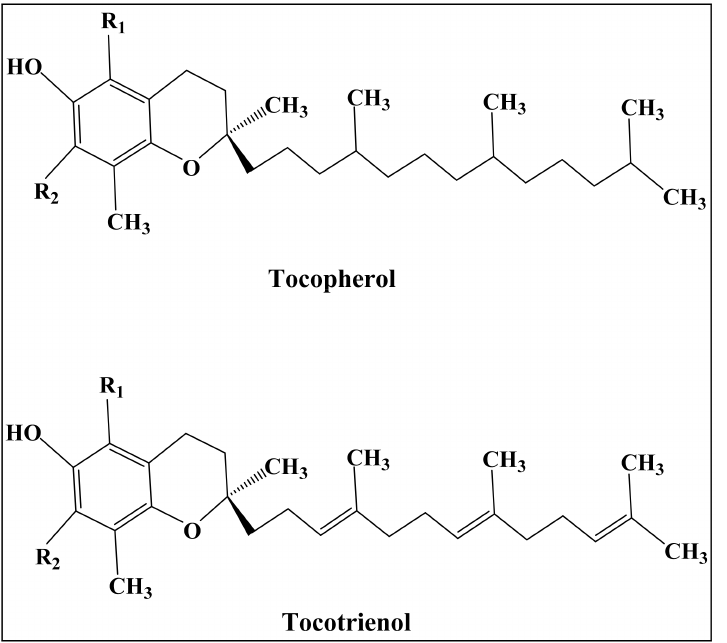
Figure 10. The chemical structure of Vitamin E analogues, type (R 1 , R 2 ): α (CH 3 , CH 3 ), β (CH 3 , H), γ (H, CH δ (H, 3 ), and